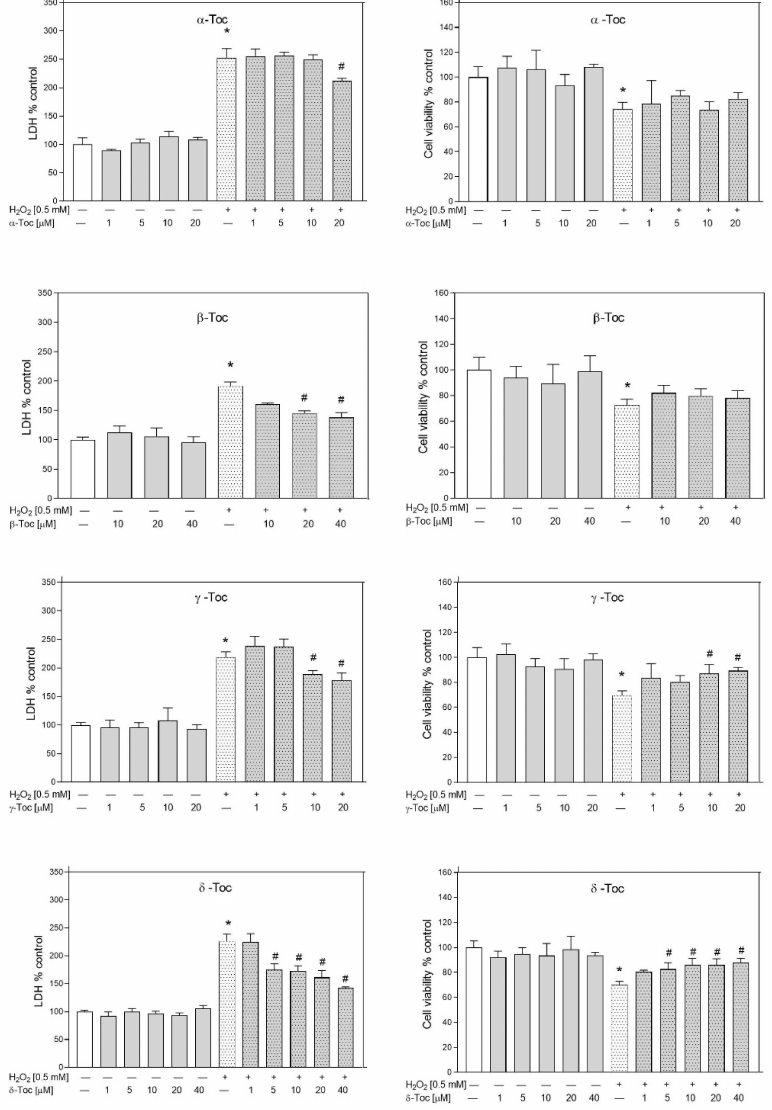
Figure 9. Effect of Tocs against H 2 O 2 -induced damage in RA-SH-SY5Y cells. The cells were pre-treated for 30 min with different ranges of Tocs concentrations (0.5–20 µ M) and PC-8 (1–20 µ M). Then, 24 h